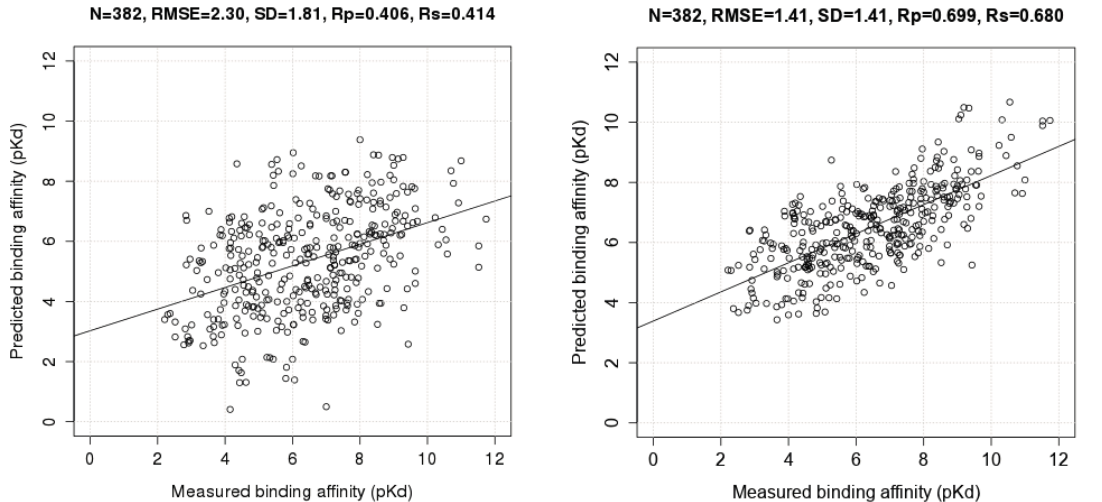
Figure 2. Correlation plots of measured and predicted binding affinities by AutoDock Vina (model 1; ( Left )) and RF::VinaElem (model 2; ( Right )) trained on the largest dataset comprising new high-quality data ( n = 3076) tested on PDBbind v2013 refined set minus v2012 refined set ( n =